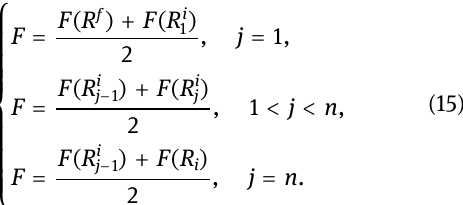
Figure 3. The mechanical properties of sub - interphase layer are obtained based on the equation ( 15 ) . Where the subscript j represents the sub - interphase layer j .